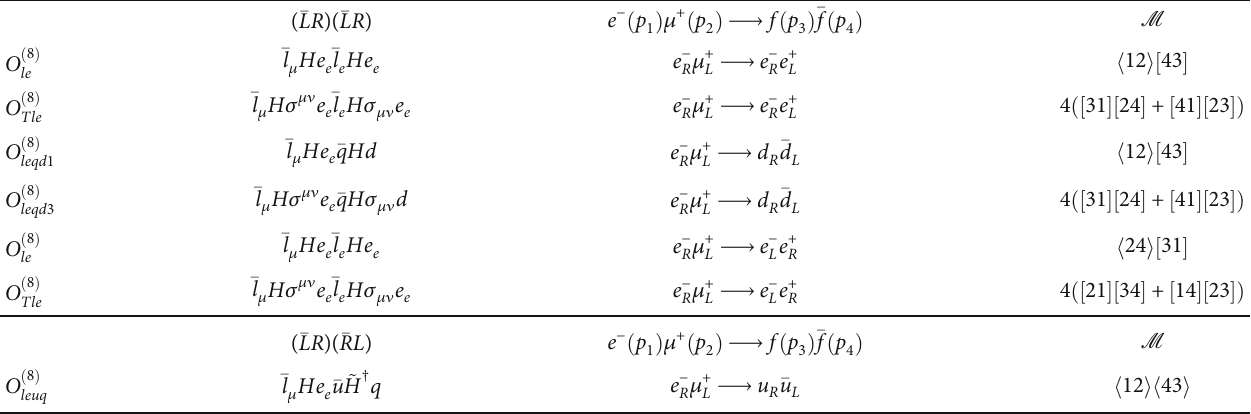
Table 2: Helicity amplitudes generated by dimension 8 operators with common fl avor indices ð 2111 Þ associated to four-fermion contact vertices that do not appear with dimension 6 operators. A ð v 2 /2 Þð C / Λ 4 Þ factor is to be included. As in Table 1, fi nal state e − e + also O (cid:1) (cid:1) stands for μ − μ + and τ − τ + , d d also stands for s (cid:1) s and b b , and u (cid:1) u also stands for c (cid:1) c